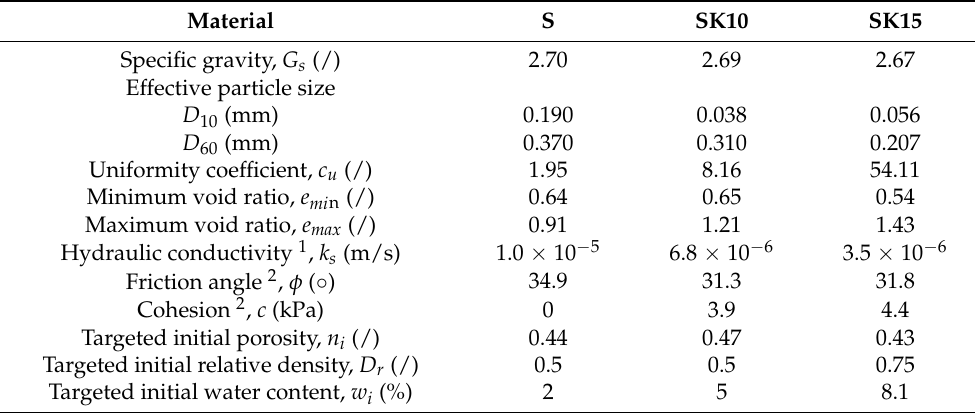
Table 1. Basic soil properties of clean sand (S) and sand with 10% (SK10) and 15% (SK15) kaolin by mass at the target initial